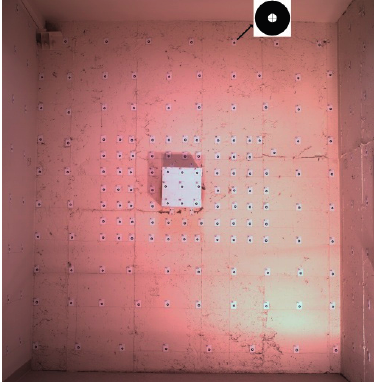
Figure 2. Camera calibration